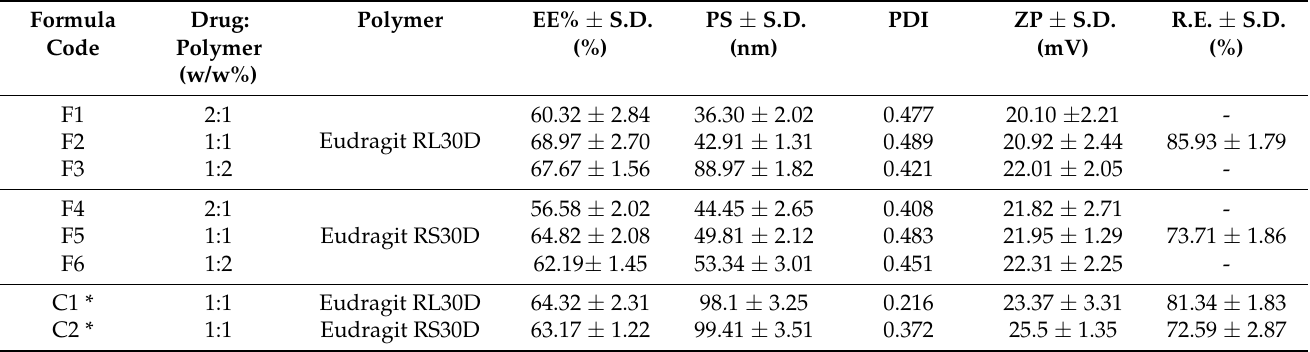
Table 1. Composition and characterization parameters of the prepared thymol-loaded polymeric